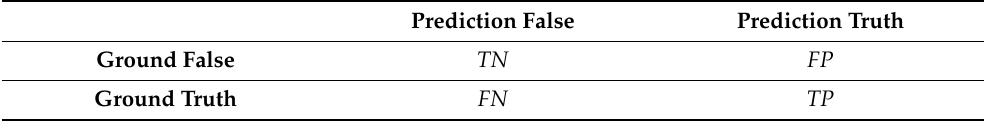
Table 1. Confusion matrix for binary classification, 1 represents landslide pixel, 0 represents back- ground pixel.